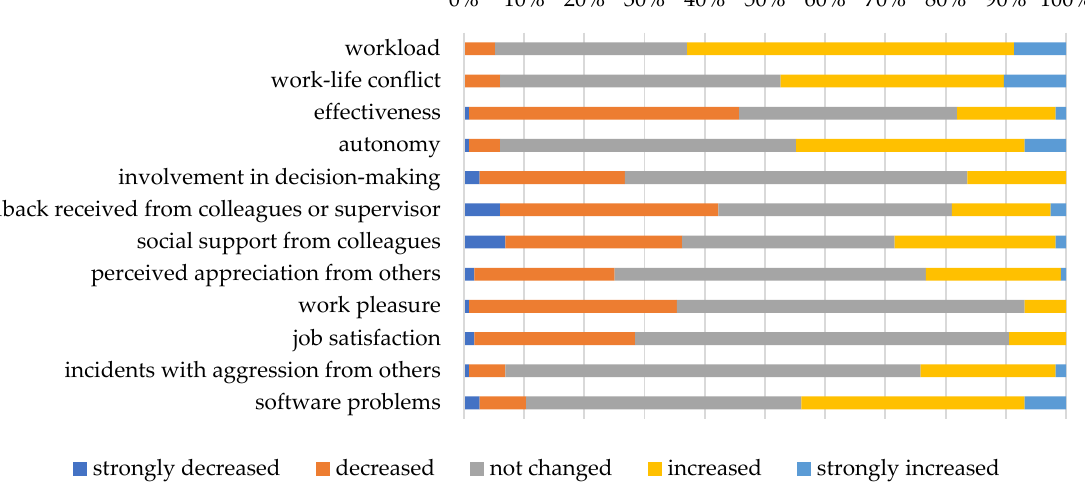
Figure 1. Perceived degree of changes in work situation since the Dutch COVID-19 measures of Table 2. Means and standard deviations of all involved total and subscale